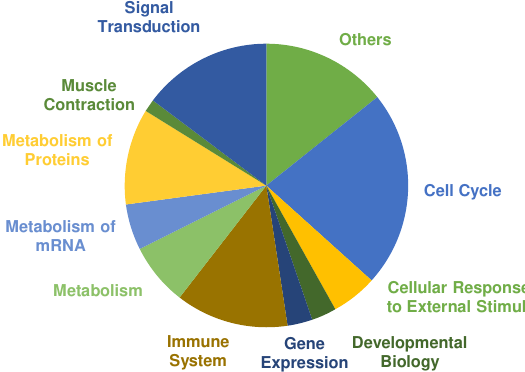
Figure 4. Pie chart shows significantly overrepresented pathways in the collagen (COL) group after 12 weeks of resistance training and supplementation analyzed by PANTHER. Size of the different colored parts indicates number of assigned pathways.